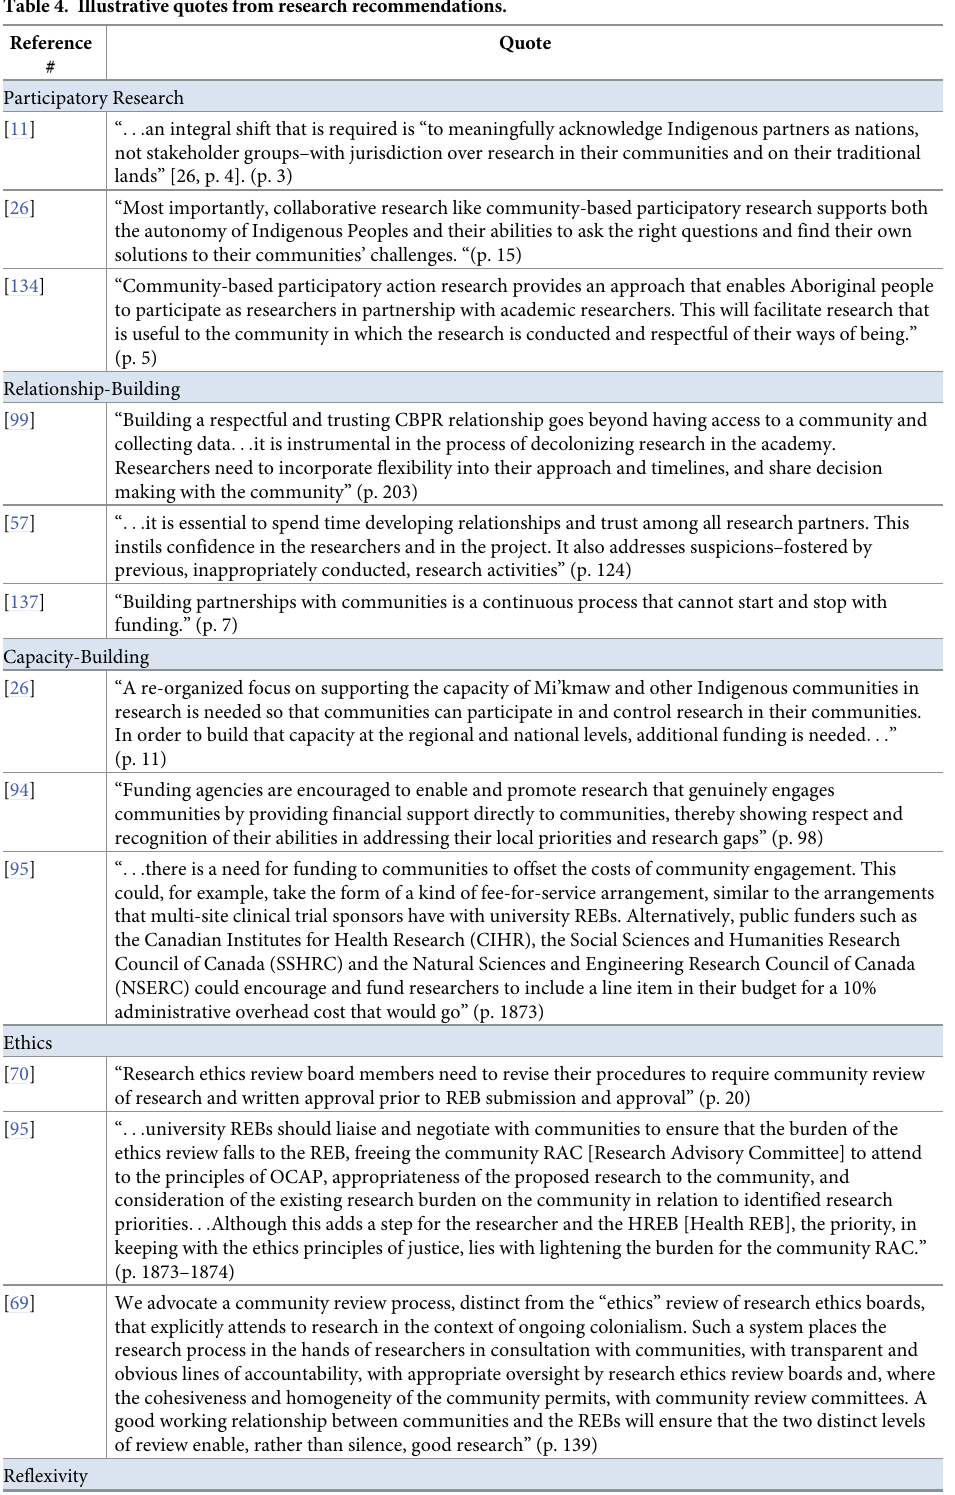
Table 4. Illustrative quotes from research